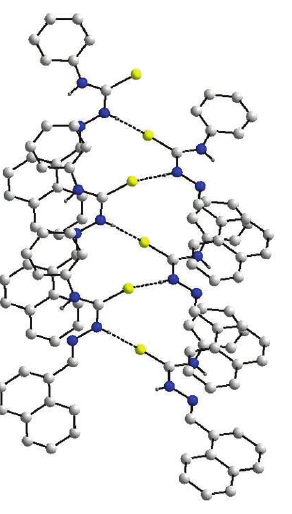
Figure 5: Helix structure of HTSC 4 in the crystal.